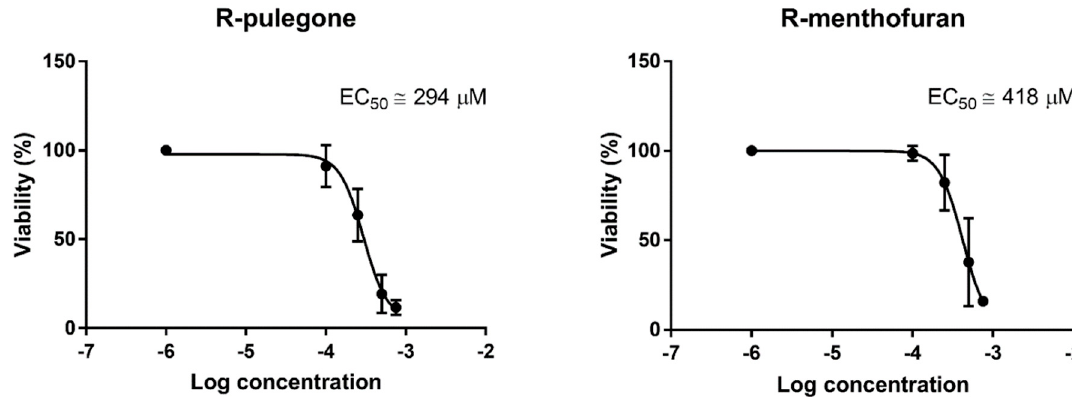
Figure 3. Non-linear regression of the effect of PUL and MF on the viability of PCLS and half-maximal effective concentration (EC 50 ) calculation. Data represent the mean ± SD from PCLS of five liver samples (PUL) and two samples (MF) showing a significant viability decrease after the treatment.